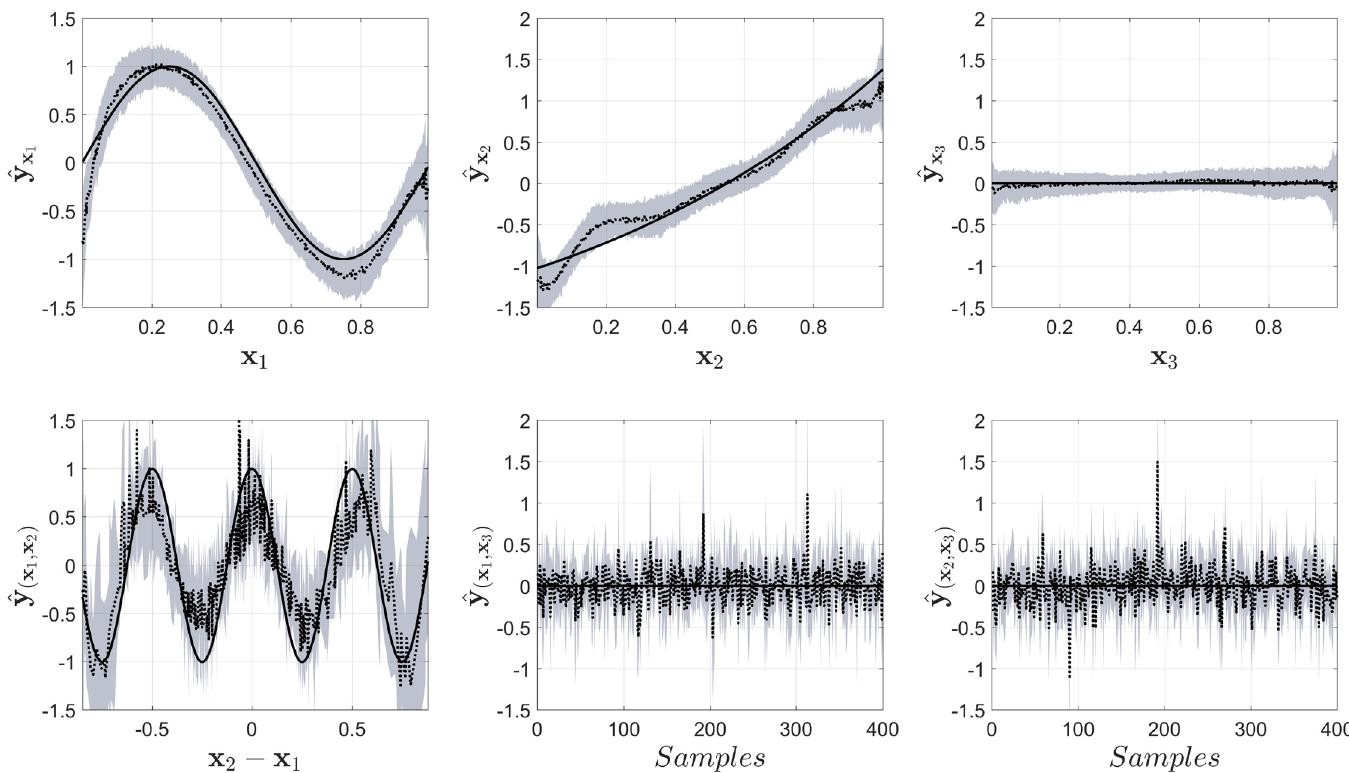
Fig 7. Output of the model for the decomposition using NObSP in the LS-SVM regression model with non-correlated inputs. The black solid line represents the true component, the dotted black line represents the mean for the estimations using NObSP, and the gray area represents the 95% confidence interval obtaining using